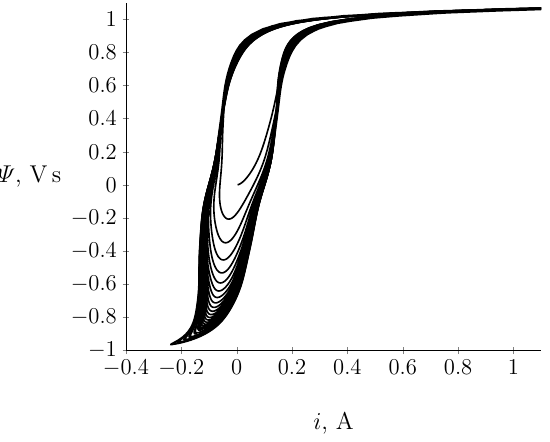
Figure 9. Phase plane Ψ ( i 1 ) of the state variables for fifteen integration periods of Equations (6) and